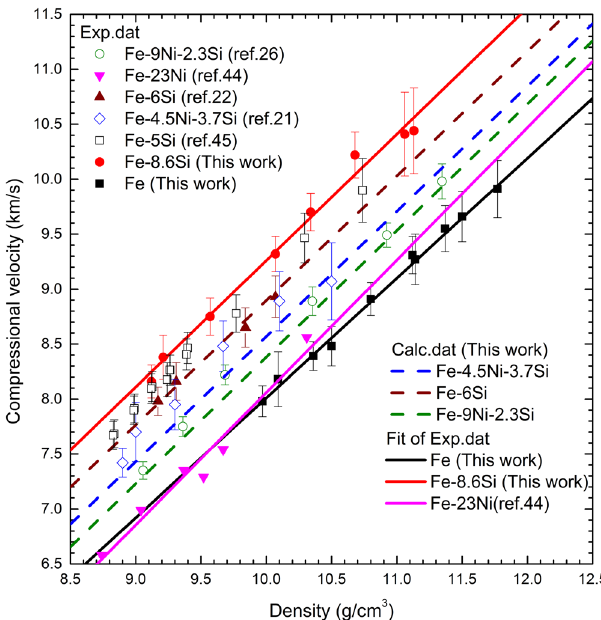
Fig. 5 The relationship between density and compressional velocity for the Fe-Ni-Si system. The black solid squares and red solid circles represent the new V P measurements for Fe and Fe-8.6Si, respectively, compared with static data for various intermediate compositions including Fe-6Si 22 , Fe- 4.5Ni-3.7Si 21 , Fe-9Ni-2.3Si 26 , and Fe-5Si 45 . The data for Fe-Ni alloy, Fe- 23Ni 44 , are also shown for comparison. The solid lines are the linear fi ts to the experimental data for the end members. The dashed lines represent the calculated V p for Fe-6Si, Fe-4.5Ni-3.7Si and Fe-9Ni-2.3Si (in weight percent) according to an ideal linear mixing model 43